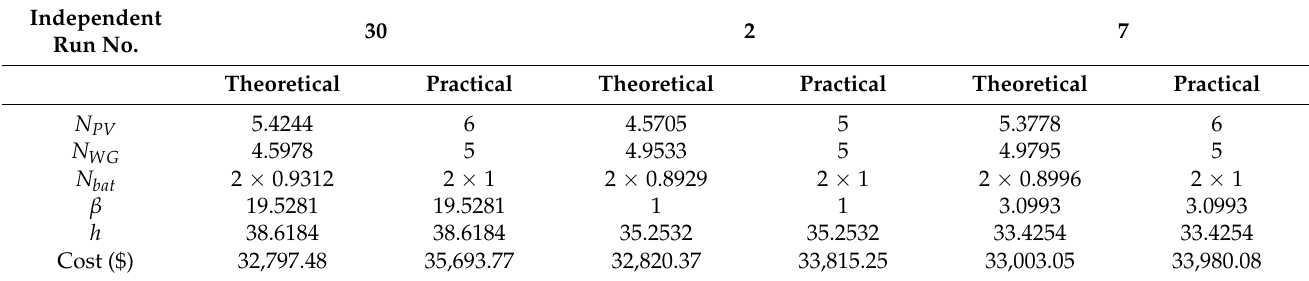
Table 7. Practical